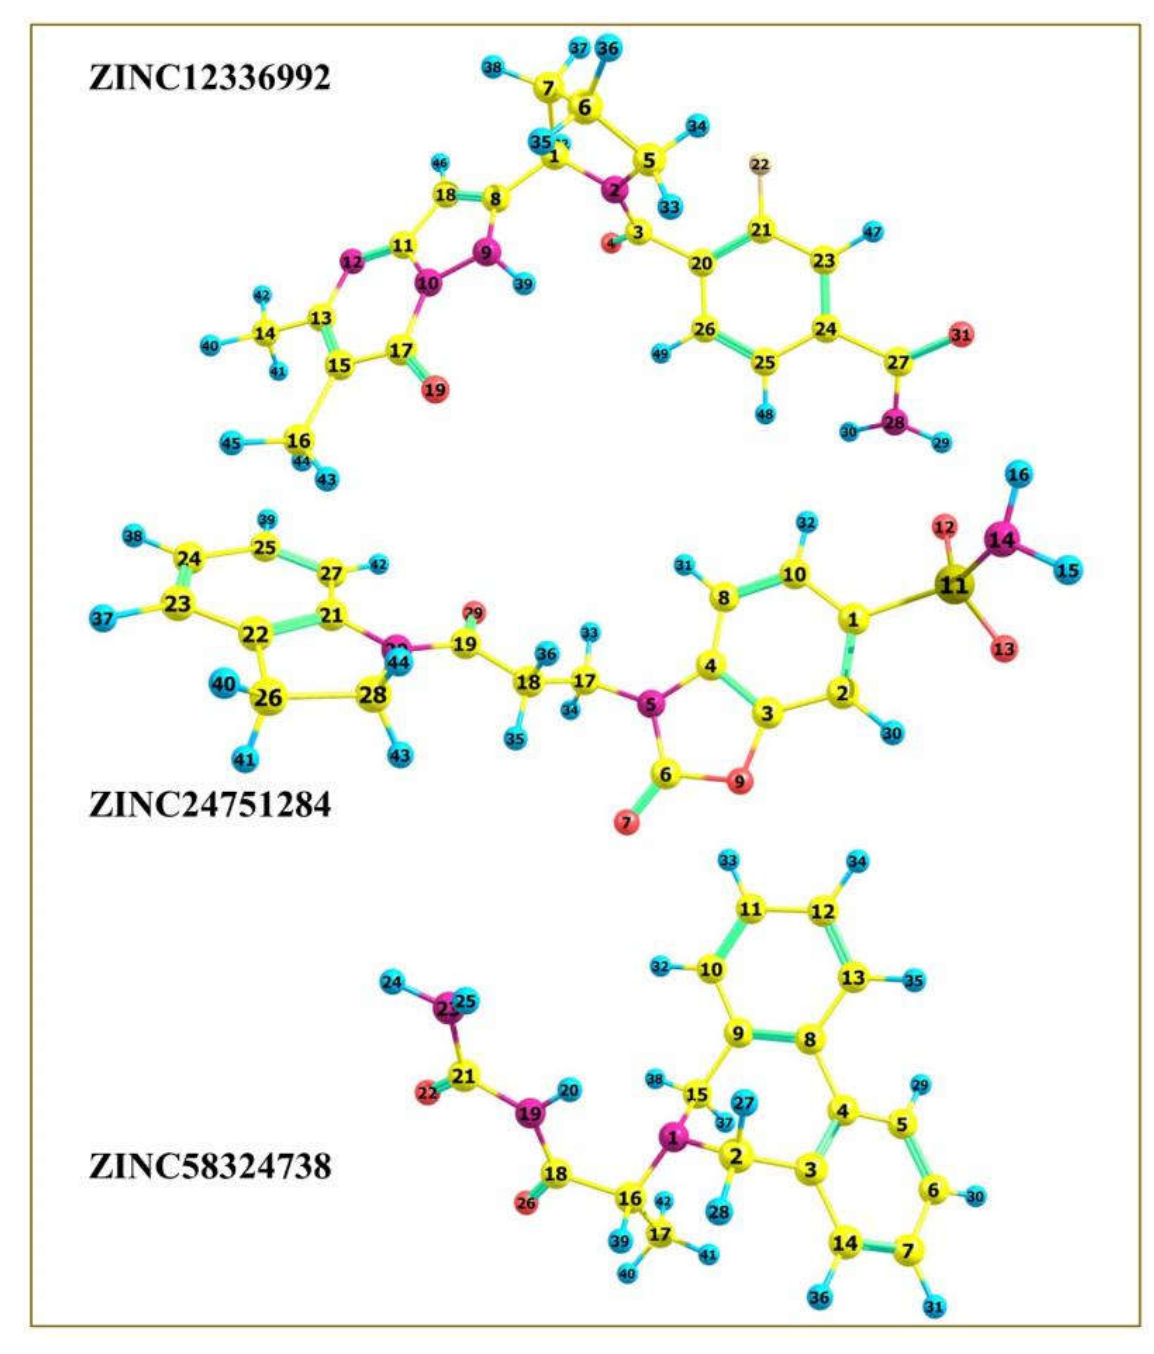
Figure 9. DFT-optimized geometry of the top three hits.